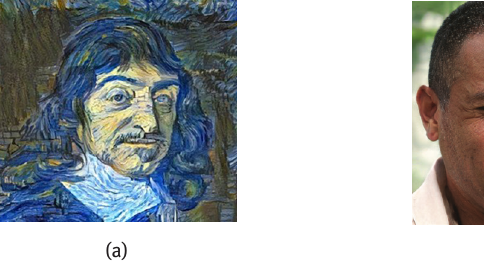
Figure 5: Different images created by a generative neural network. (a) An image of Descartes in the style of Van Gogh’s pain- tings, based on the model of Gatys et al. (2016). (b) Faces of non-existent people.59 The predictive processing theory of the brain suggests that information is not only processed upstream from lower-level cortical regions that are closer to the sensory input and moved to higher cortical regions, but also vice-versa. The theory states that this process does not simply occur occasionally, but occurs continuously. In the case in which discriminating, bottom-up information flow dominates the generative net component, the brain projects less prior structure onto lower cortical regions, thereby inflicting only small changes on the data. In the reverse case, however, the input data might get completely distorted by the generative network. The brain can generally control the degree to which things are imagined. Under normal circumstances—where the subject is neither dreaming, taking psychedelic drugs, nor suffering from certain mental disorders—the imagined and the real are neurologically distinguished by the brain’s attention to information flow. The significance of simulations here is that they provide proof for the possibility of such a network, and subsequently help answer the question of how fictional objects are distinct from “real”